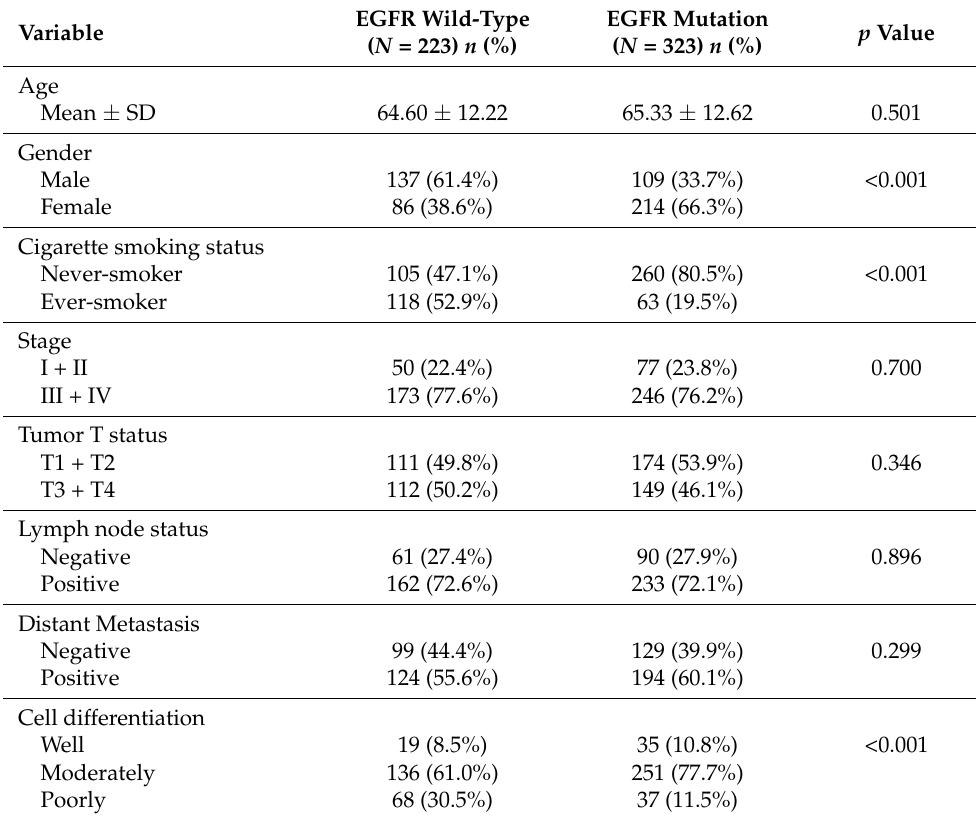
Table 1. Demographics and clinical characteristics of 546 patients in lung adenocarcinoma with EGFR mutation